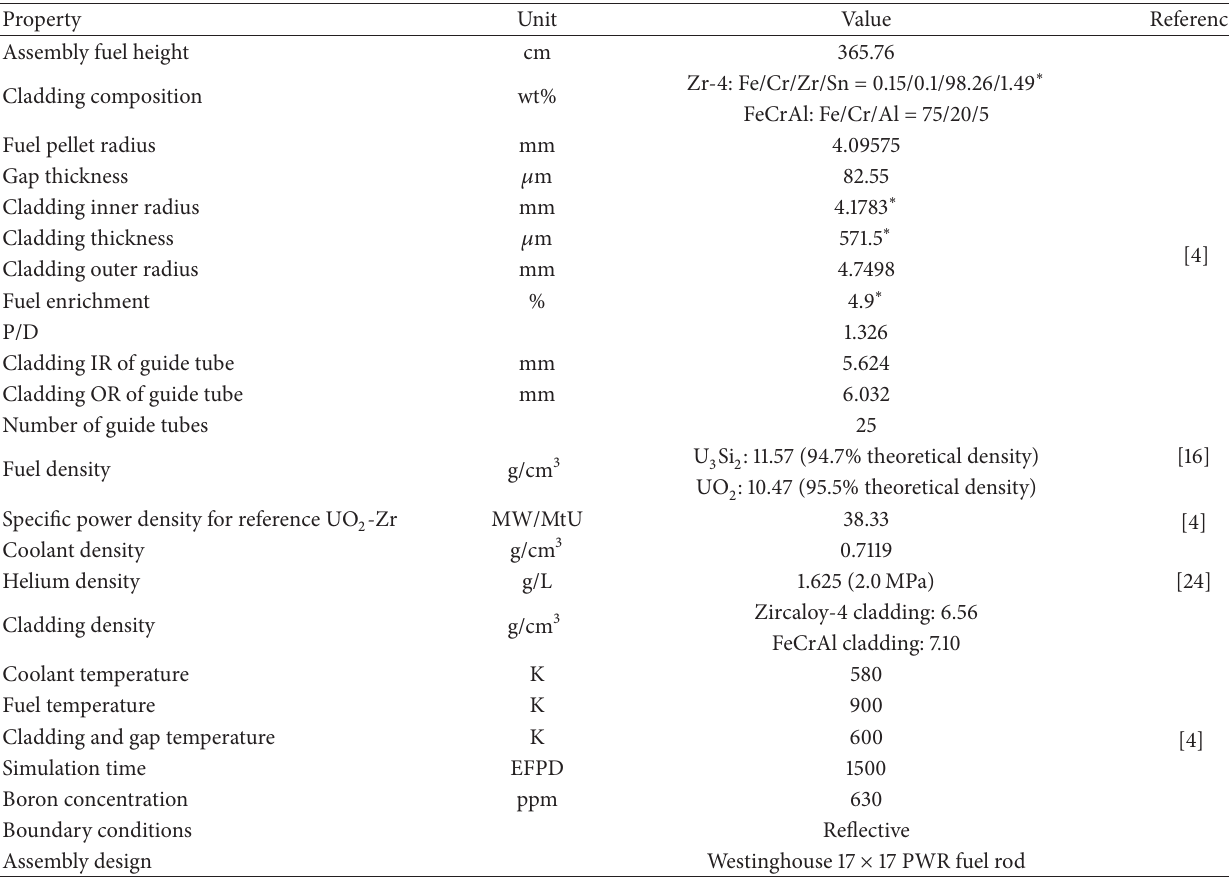
Table 1: Model specification.